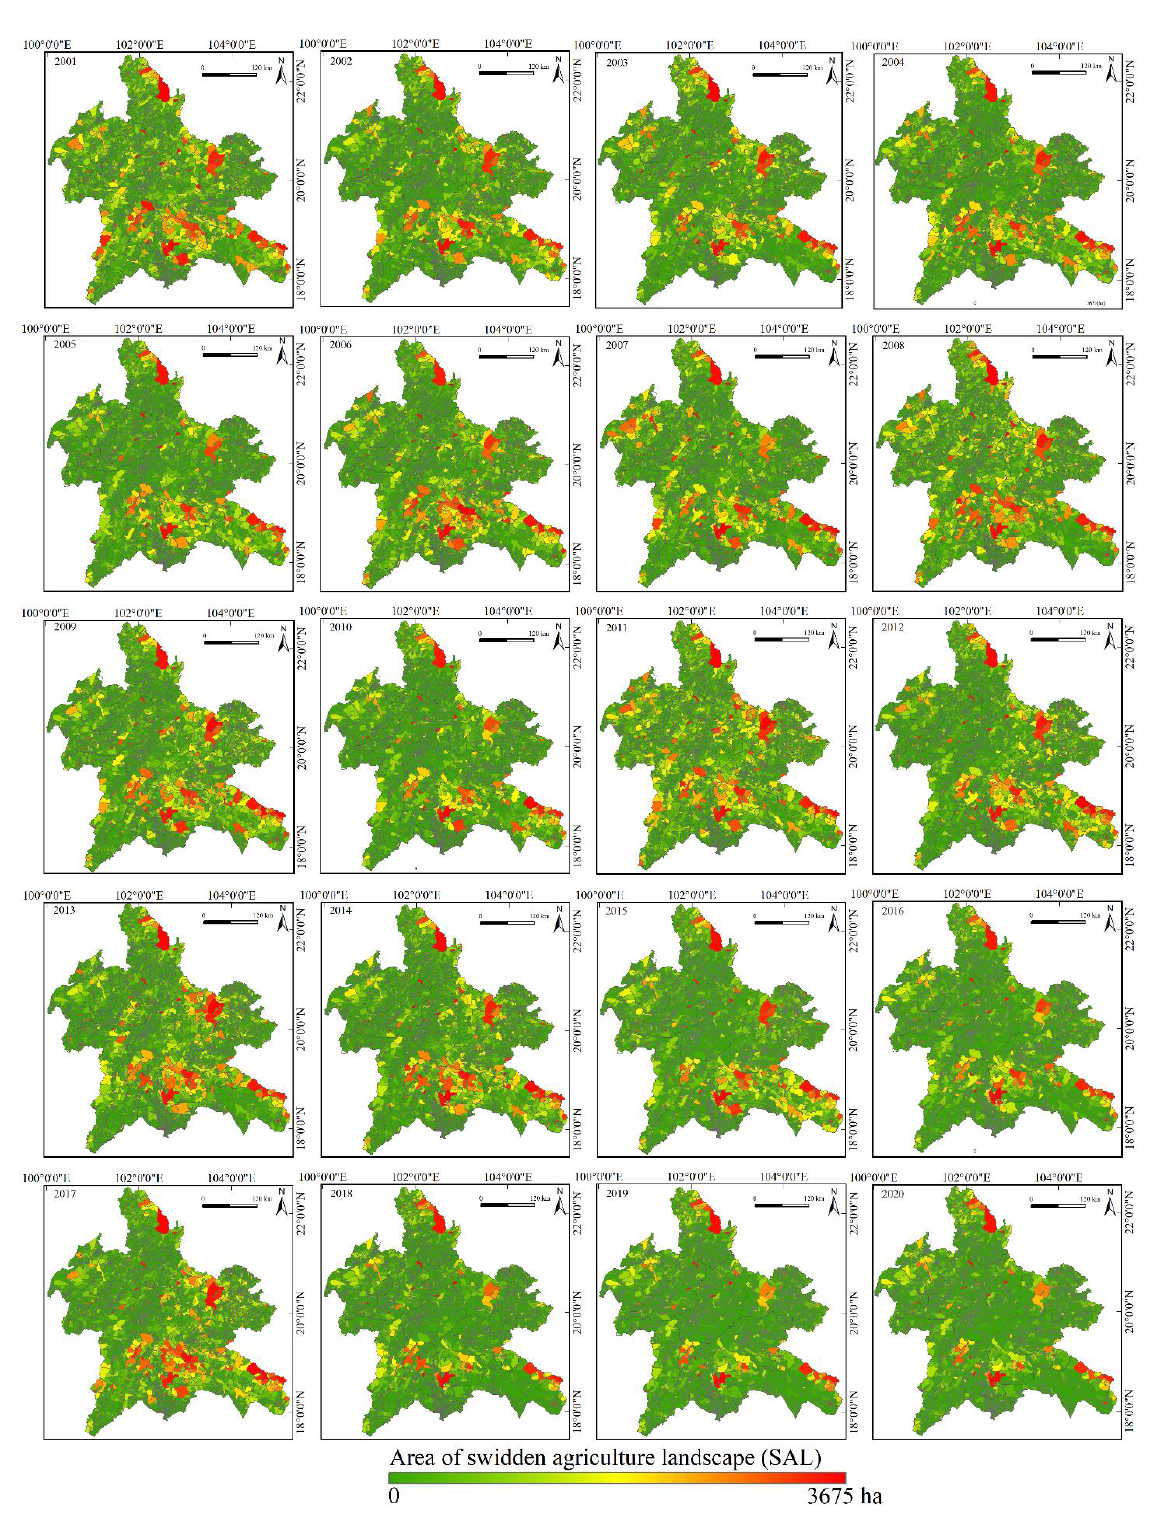
Figure 8. Annual dynamics of swidden agriculture landscape (SAL) at the village level in northern Laos during 2001 – 2020.